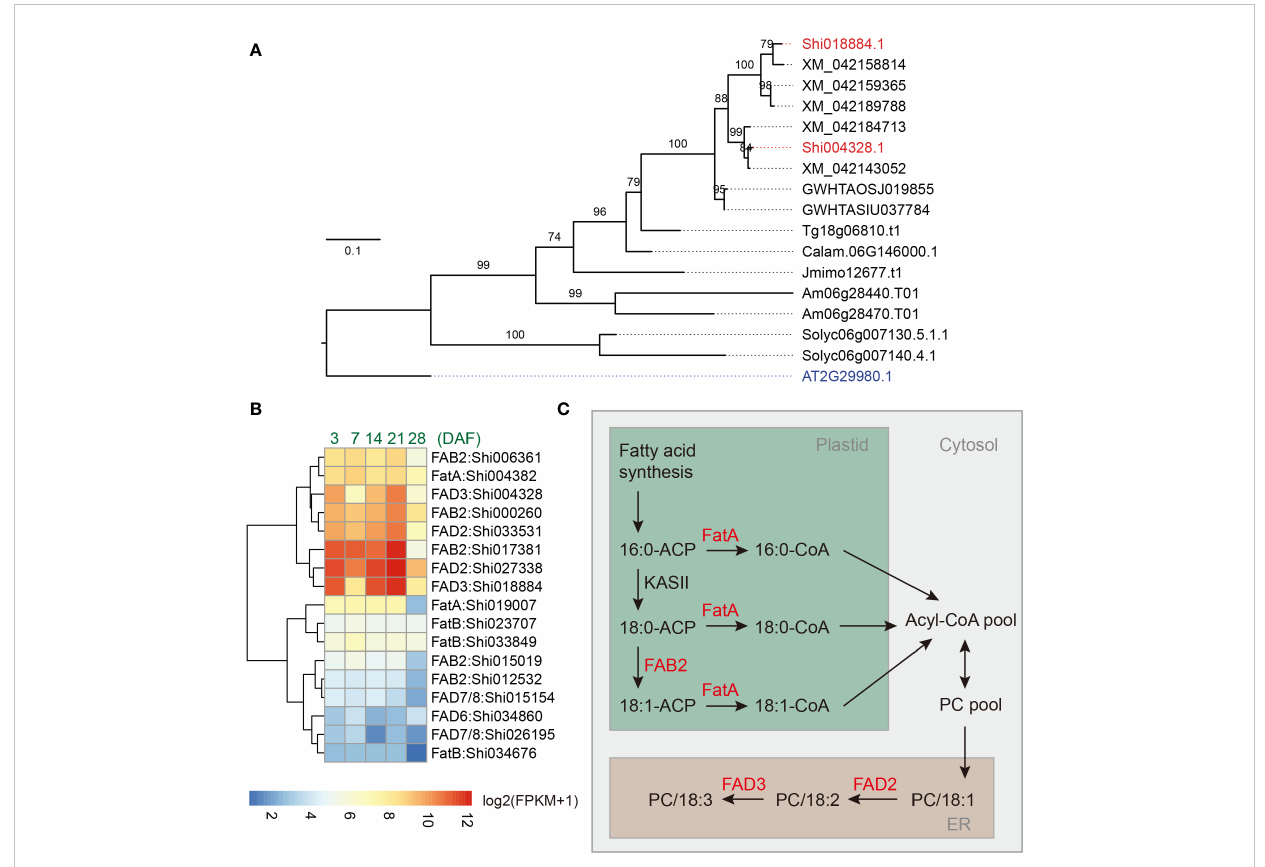
FIGURE 4 Identi fi cation of critical genes involved in fatty acid biosynthesis of chia seeds. (A) Phylogenetic tree of the FAD3 genes. Shi: Salvia hispanica ; AT: Arabidopsis thaliana ; XM: Salvia splendens ; GWHTAOSJ: Salvia miltiorrhiza ; GWHTASIU: Salvia bowleyana ; Tg: Tectona grandis ; Jmimo: Jacaranda mimosifolia ; Calam: Callicarpa americana ; Am: Antirrhinum majus ; Solyc: Solanum lycopersicum . (B) Expression pattern for FatA , FatB , FAB2 , FAD2 , FAD3 , FAD7/8 , and FAD6 genes in developing chia seeds. DAF: Days after fl ower opening; FPKM: Fragments Per Kilobase of transcript per Million mapped reads. Only genes with maximum FPKM > 1 in seed samples were included in the plot. (C) A model for the biosynthesis of ALA in the chia genome. PC, phosphatidylcholine; ER, endoplasmic